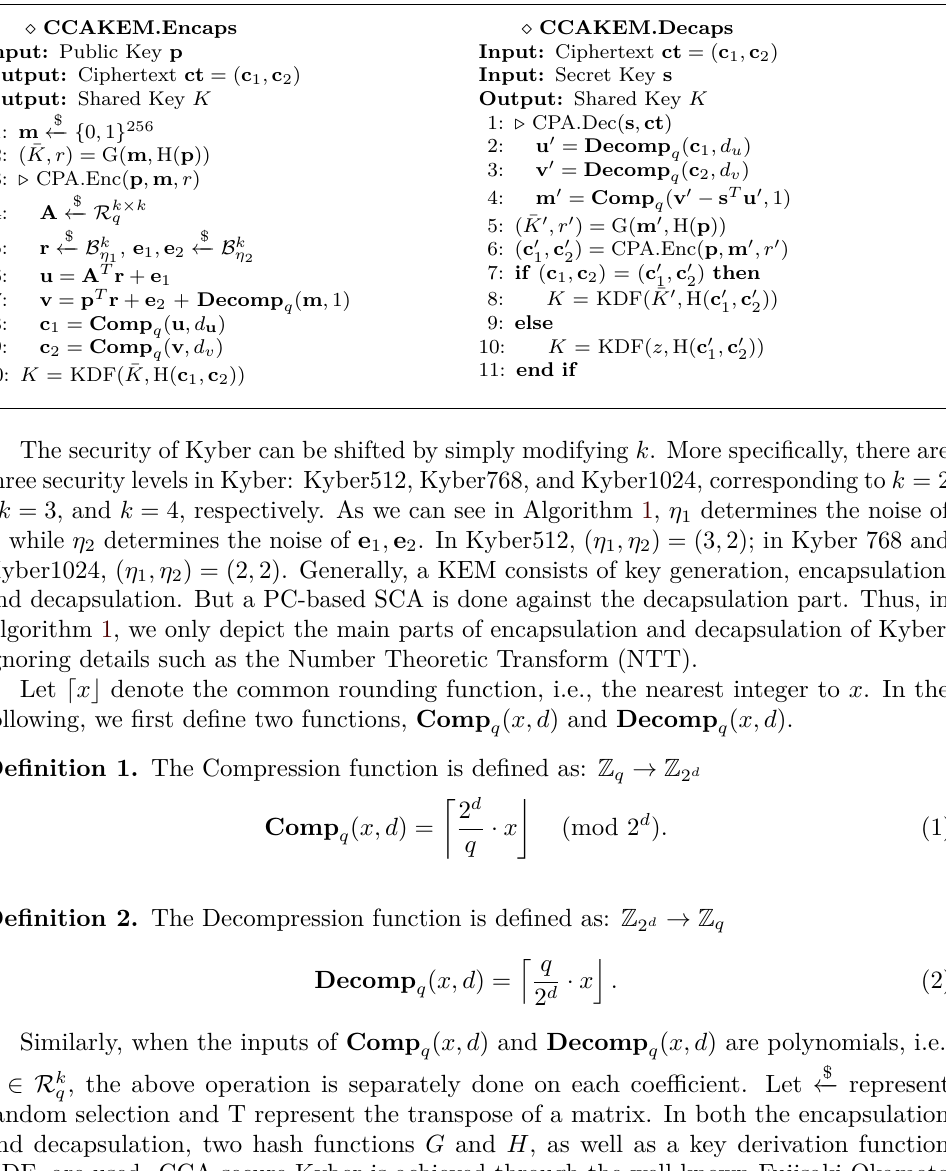
Algorithm 1 The encapsulation and decapsulation in